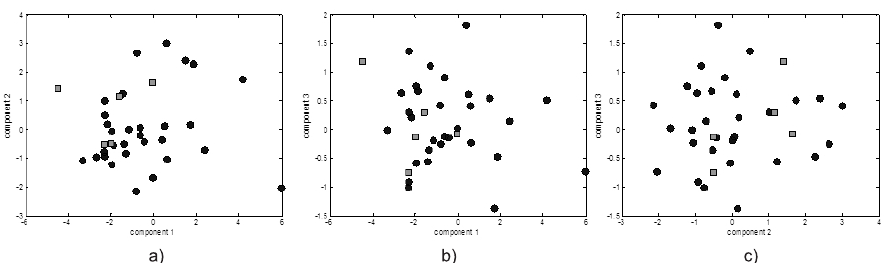
Figure 9. Observations from treatment group divided into groups of trans- plantation indication on principal component axes